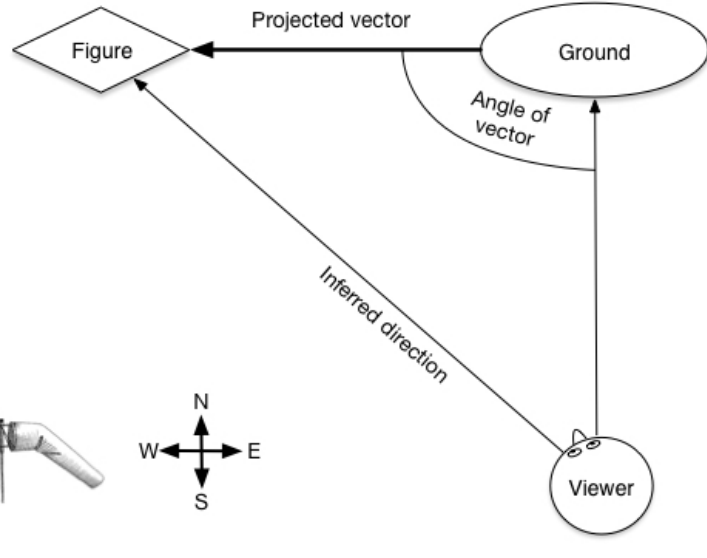
Figure 3: Vector projection within an absolute frame of reference (e.g., the Figure is west / upwind of the Ground).